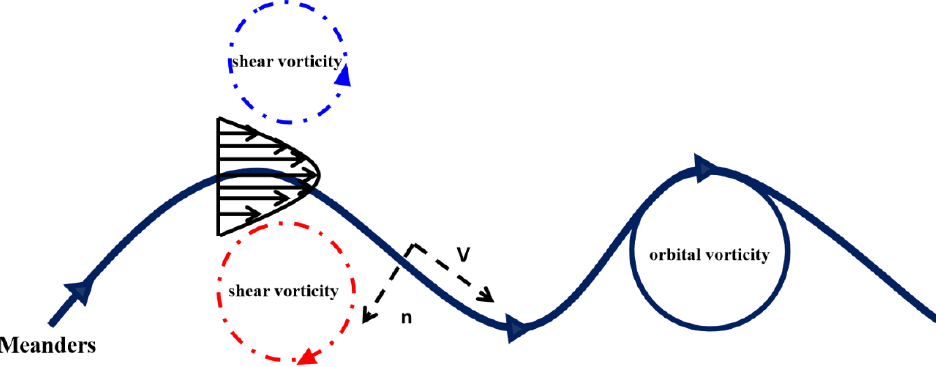
Figure 11. Schematic diagram of the shear vorticity and orbital vorticity of the meander